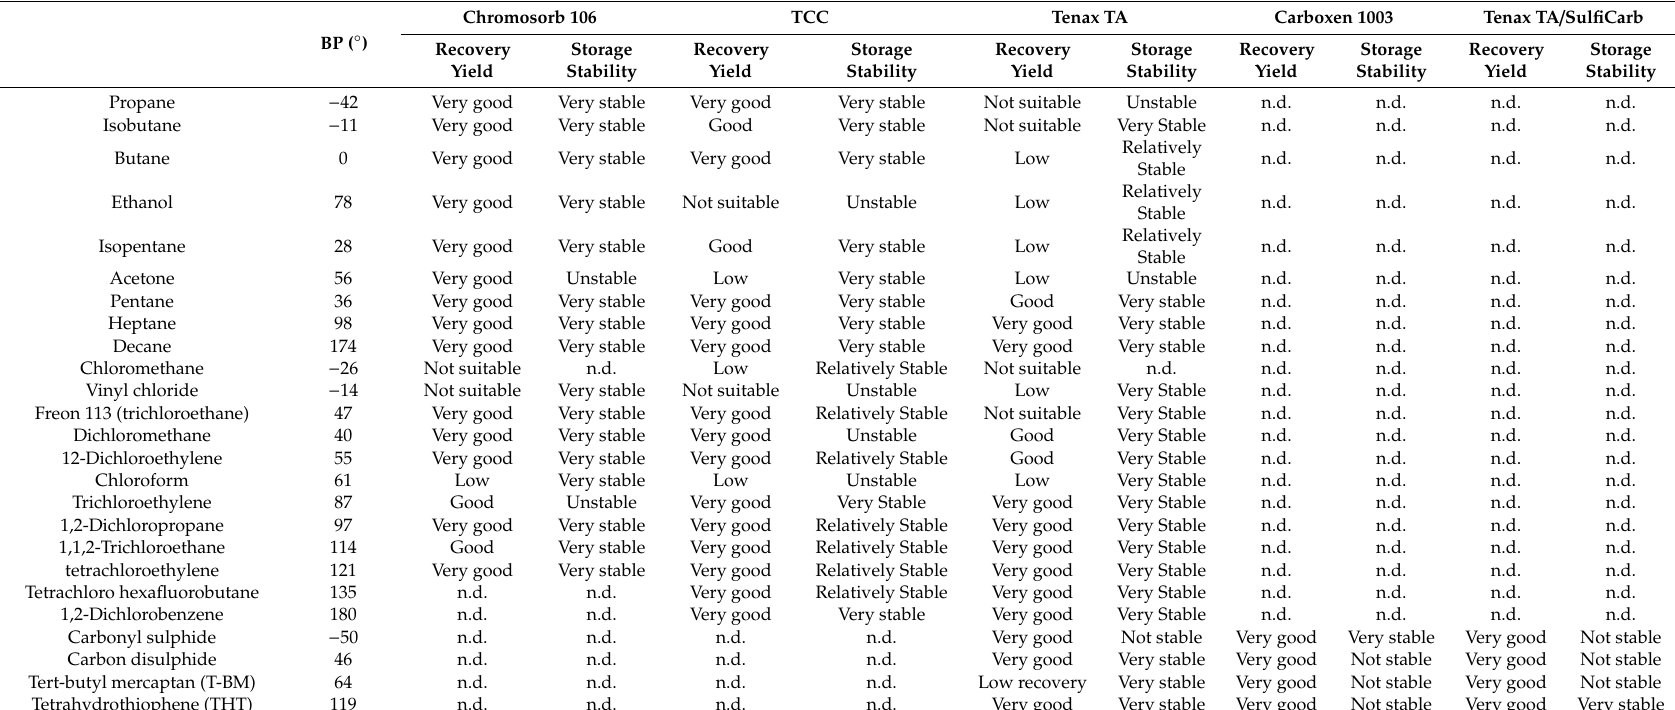
Table 8. Suitability of sorbents for the targeted